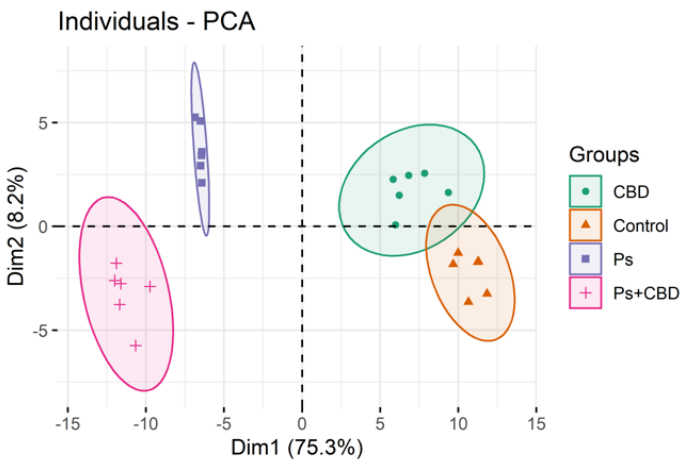
Figure 1. Two-dimensional principal component analysis (2D PCA) scores plot of the relative abundance of phospholipid species in keratinocytes, isolated from the skin of healthy subjects (Control) and psoriatic patients (Ps). These cells were not treated or treated with CBD (4 μM). The following groups of keratinocytes were examined: Control, CBD, Ps, and Ps + CBD. All samples were analyzed after 24 h of treatment.